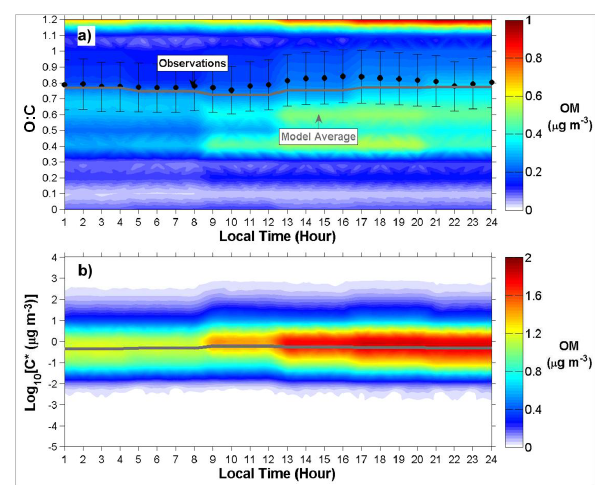
Figure 4. Diurnally averaged a) O:C distribution for a representative day during the Finokalia 955 Fig. 4. Diurnally averaged (a) O:C distribution for a representative Aerosol Measurement Experiment. Black circles represent measurements averages while the 956 day during the Finokalia Aerosol Measurement Experiment. Black circles represent measurement averages while the gray line corre- gray line corresponds to the model average as it evolves throughout the day. Error bars denote 957 sponds to the model average as it evolves throughout the day. Error 20% deviation from the measurement. b) OA volatility distribution for the same representative 958 bars denote 20% deviation from the measurement. (b) OA volatil- day in May 2008. The gray line here represents the model average of the OA volatility. 959 ity distribution for the same representative day in May 2008. The 960 gray line here represents the model average of the OA volatility.